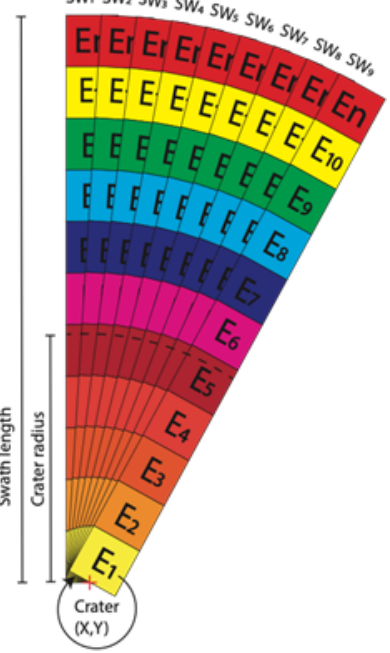
Figure B1. A graphical representation of the methodology used to quantify dome collapse PDC travel direction probabilities. Radial swaths (SW i ) are initiated from the crater start point ( X,Y ). For each distance step from the start to the full swath length, populations of elevation values E i (represented by cells of the same colour) are compared and the percentile